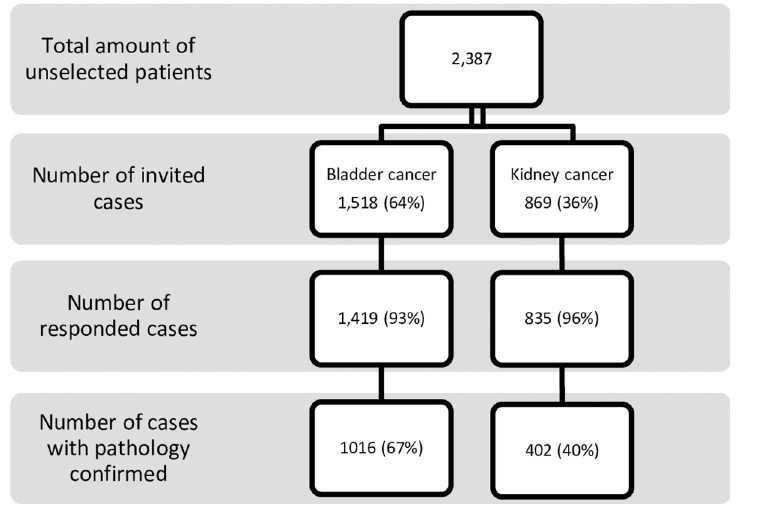
Fig 1. Diagram with the group included in the